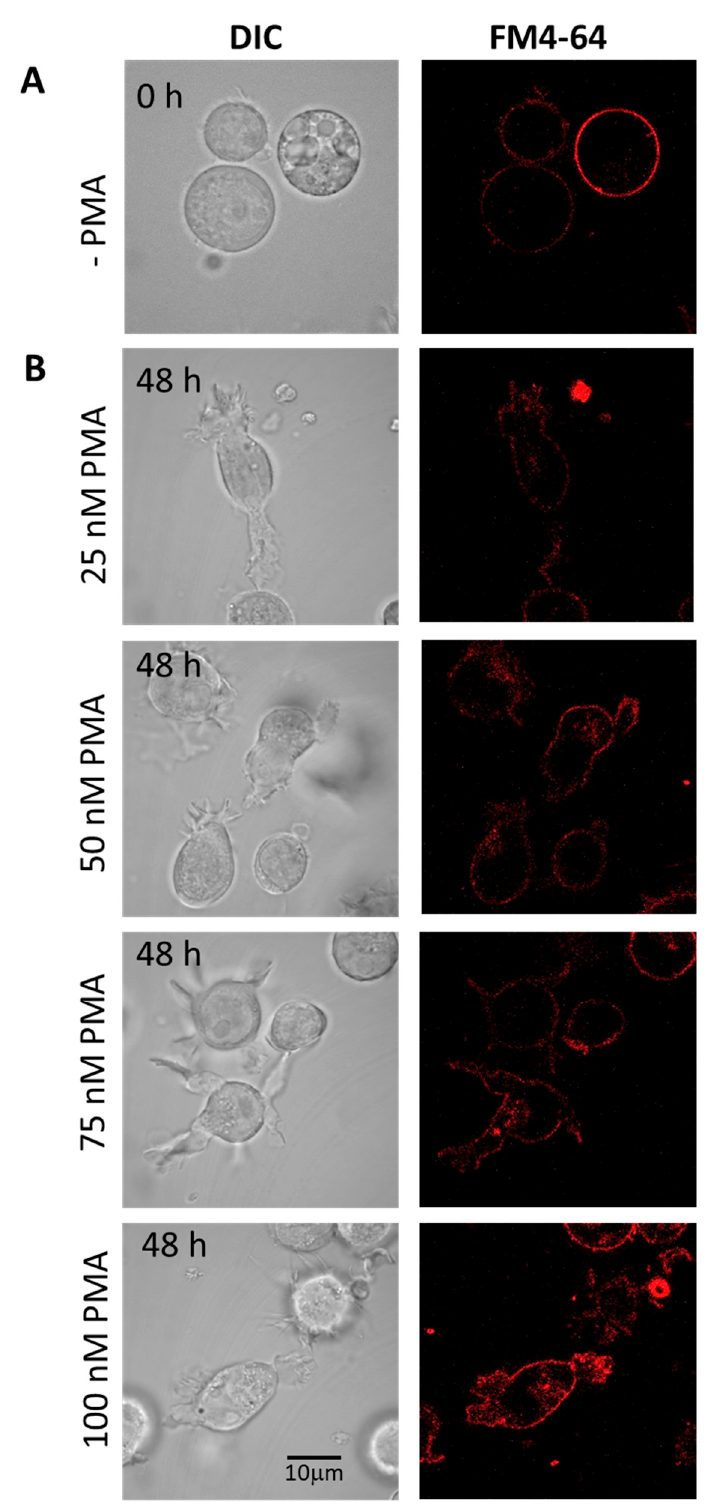
Figure 4. Staining of HL-60 with FM4-64 (5 min, RT) visualizing membrane integrity in non-differentiated ( A ) and 48 h differentiated ( B ) HL-60 cells. In B, the panels show cells treated with 25 nM, 50 nM, 75 nM, and 100 nM PMA. Individual channels for DIC and FM4-64 (red signal) are presented.